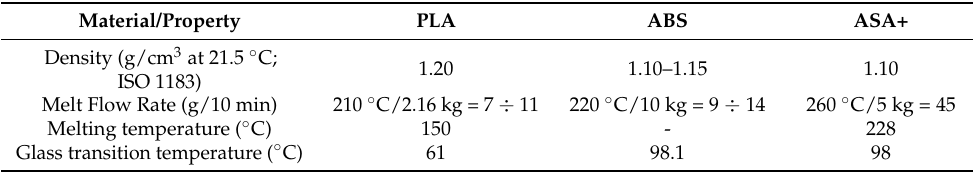
Table 1. Physical properties of used polymer materials and filament [31–33].